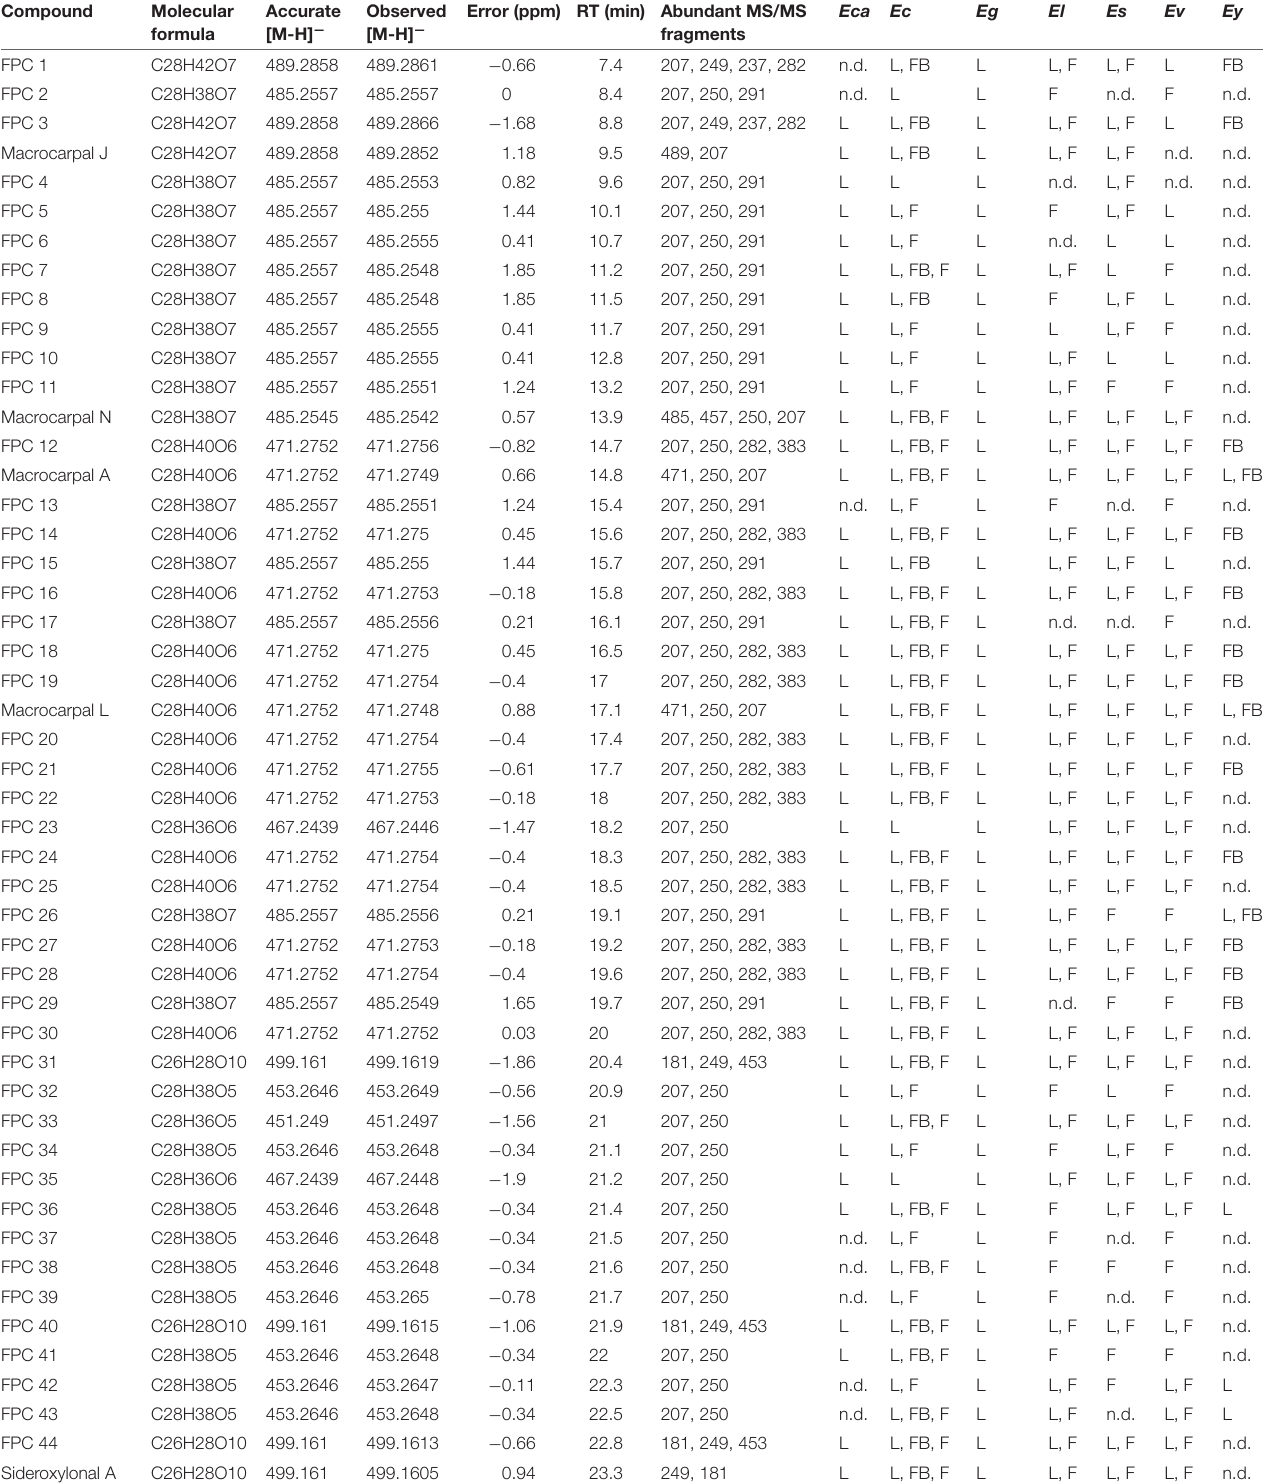
TABLE 1 | FPCs detected in methanol extracts of Eucalyptus samples (leaf, flower bud, and flower) analyzed by UHPLC-DAD-ESI-Q-TOF-MS/MS.